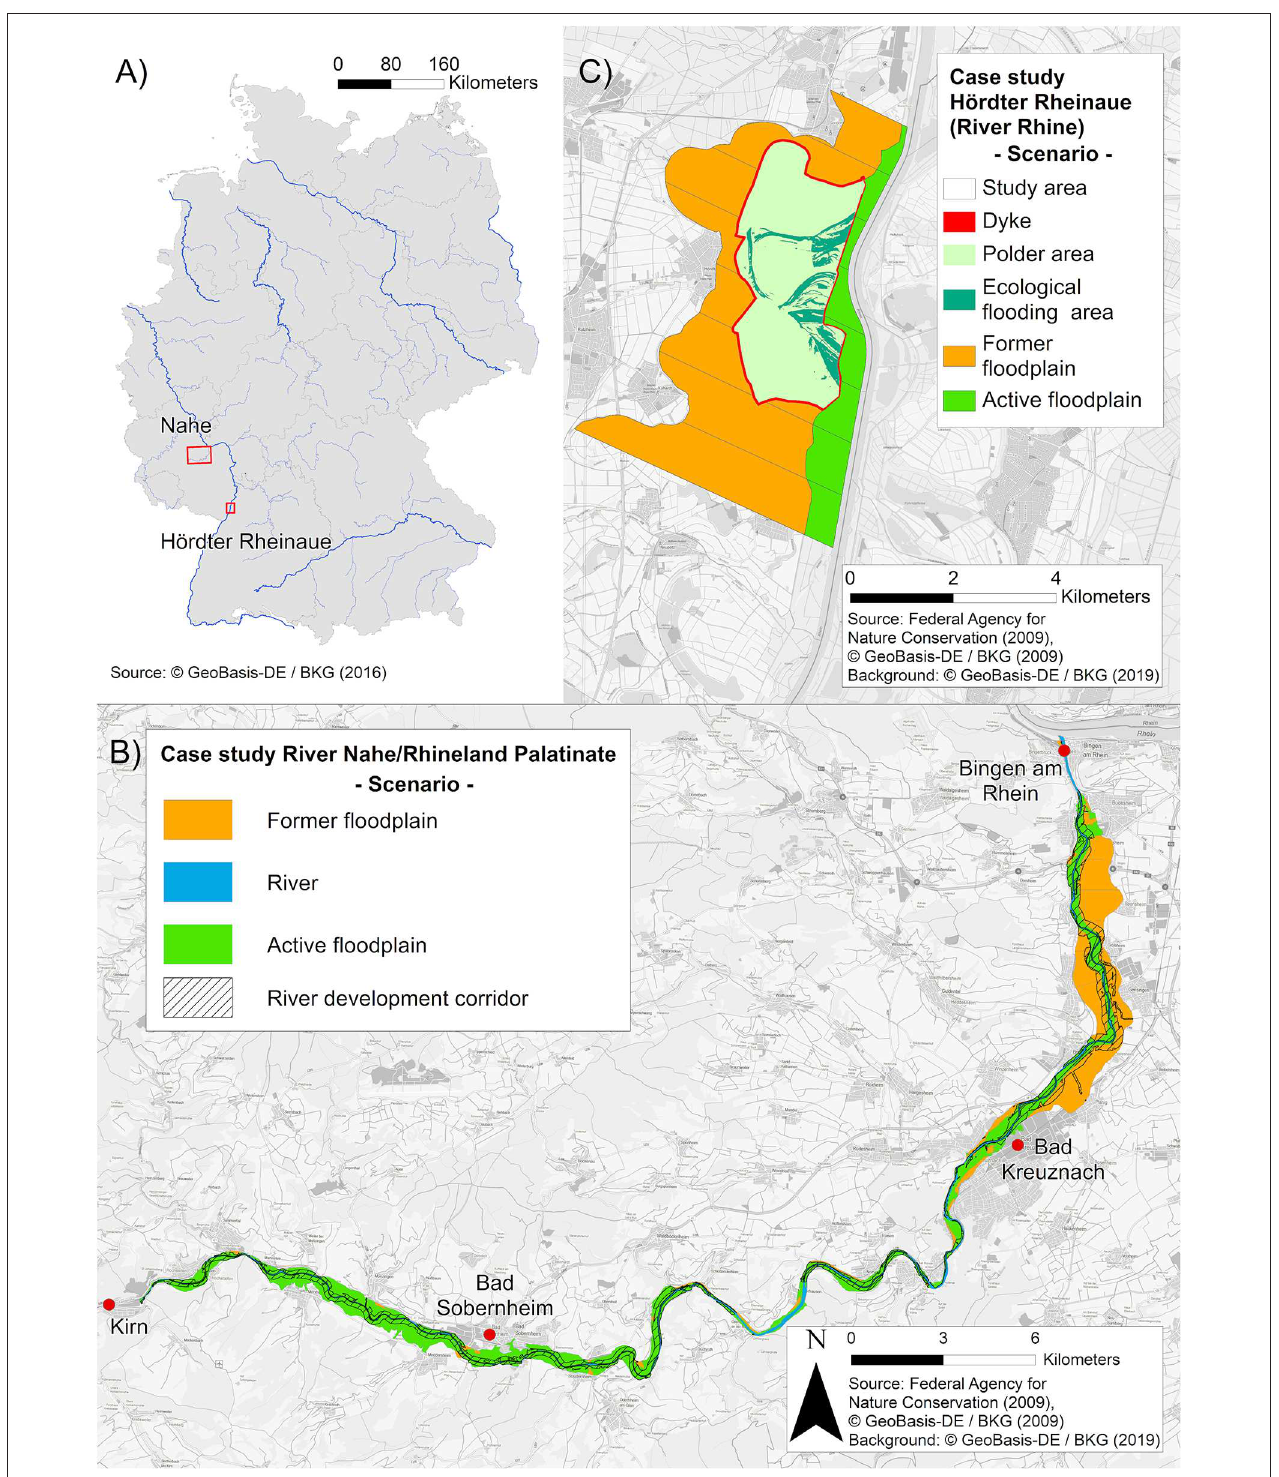
FIGURE 2 | (A) Map of federal states and rivers in Germany. The two case studies are localized by red boxes. (B) Case study River Nahe: floodplain compartments active (light green) and former (orange) floodplain, river (blue), and area for the water development corridor (black striped area) of the scenario. River floodplain corridor = the area potentially available for the restoration of rivers and its floodplains in order to bring them into a good or very good ecological status. Red dots indicate larger towns. (C) Case study Hördther Rheinaue along the River Rhine: floodplain compartments active (light green) and former (orange) floodplain and river (blue). Dyke (red) and polder area (light green area) of the